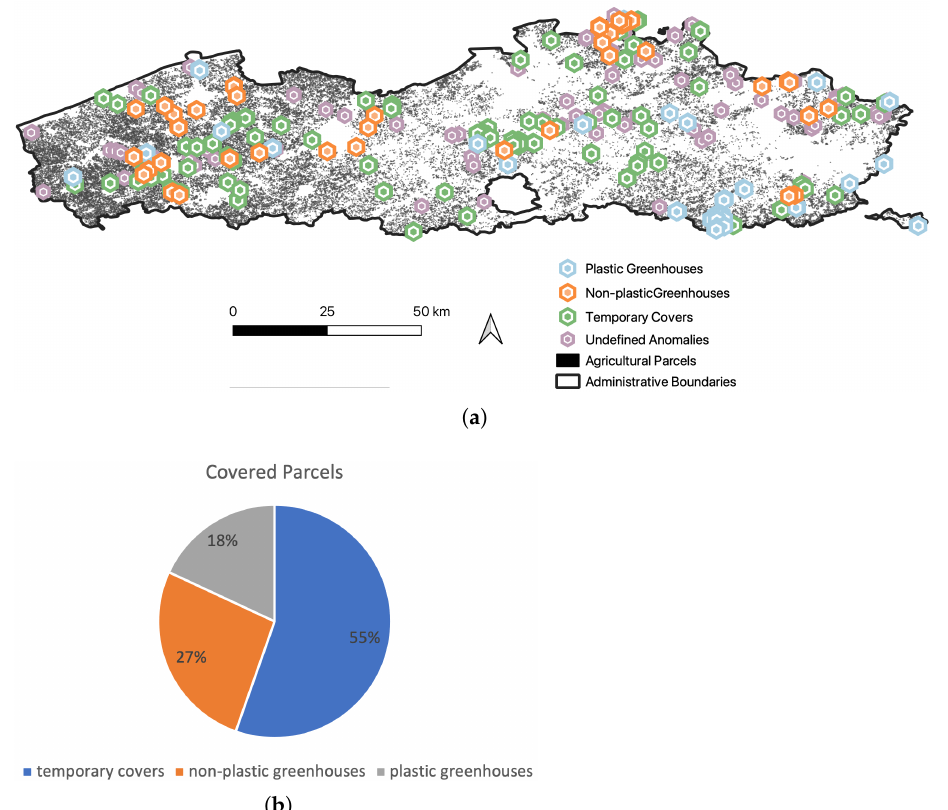
Figure 18. Overview of detected covered parcels using Sentinel-2 data acquired in April–May 2020 satisfying NDVI < 0.3, using the 3 top ranked acquisition dates. ( a ) A map of detected fragmented agricultural parcels in Flanders with artificial covers. ( b ) Fraction of soil covers in the detected 166 parcels of artificial